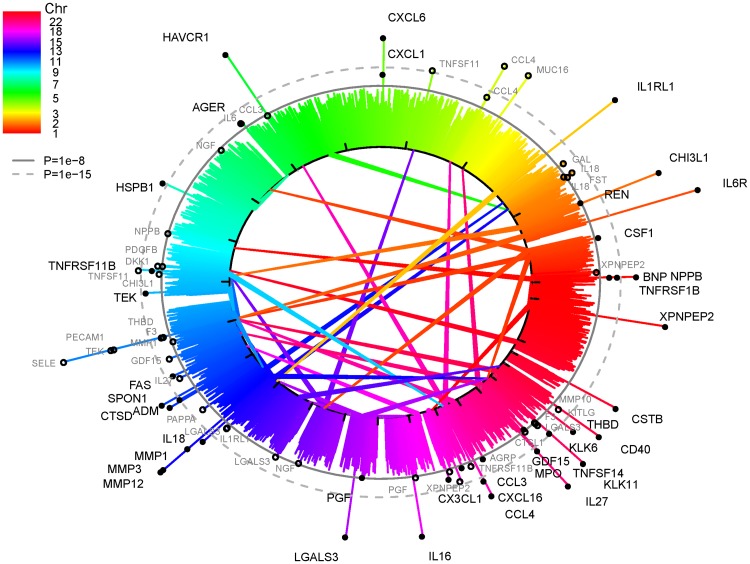
Genome-wide association strength of all measured plasma proteins.The extent of each stack indicates the negative log P of association between the plasma protein and SNPs. Stacks with black dots and black text labels indicate cis-associations. Stacks with hollow circles and grey text labels indicate trans-associations; their targets are indicated with central colour coded lines. Consequently, plasma proteins having both cis- and trans-effects can be identified as those with a black dot stack as well as connecting lines from hollow dots, e.g. XPNPEP2 or CCL4. Fully drawn circle shows P = 5e-8. Dashed circle shows 1e-15. A detailed table of the genome-wide significant associations in this figure is available as supplemental S1 Table. A zoomable and interactive version of this figure is available at www.olink-improve.com.